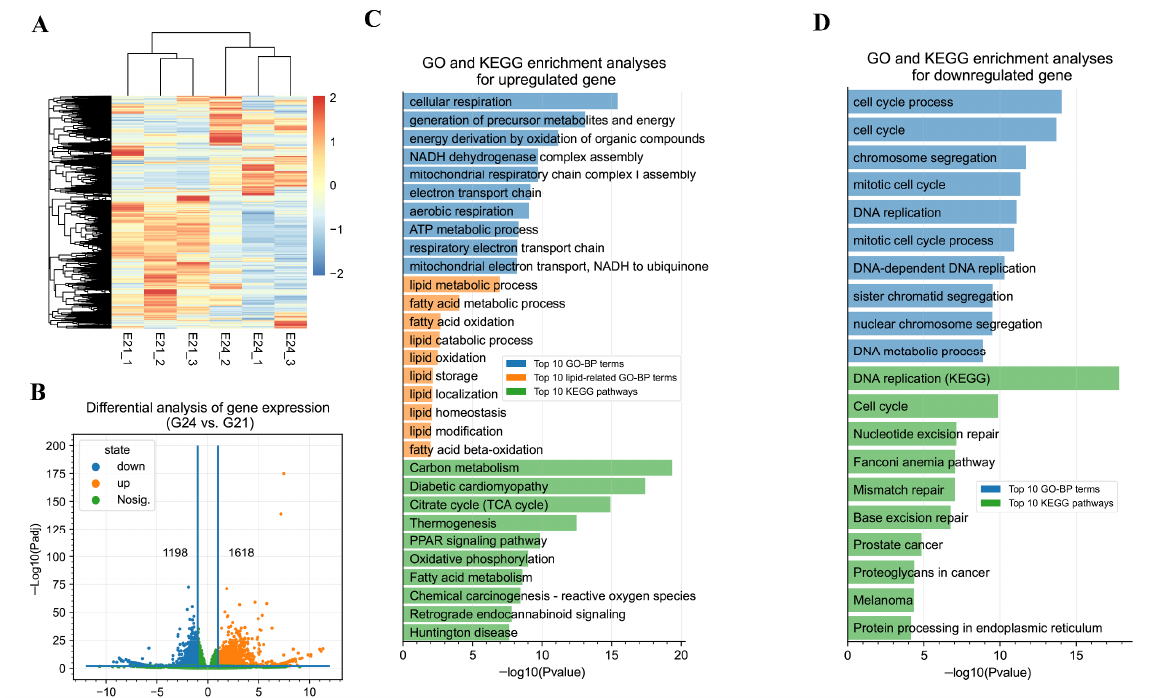
Figure 2. Deep RNA-seq reveals transcriptome changes during the early development of fetal BATs (FBATs). ( A ) Heatmap analysis and hierarchical clustering of samples using normalized read counts (TPM values) of the transcriptome. Each row shows one gene, and the TPM values were Z-scaled by row. The scale bar shows the Z-scaled TPM values. ( B ) Volcano plot showing significantly up- and downregulated genes from G21 to G24. ( C ) GO and KEGG analyses of upregulated genes. ( D ) GO and KEGG analyses of downregulated genes.